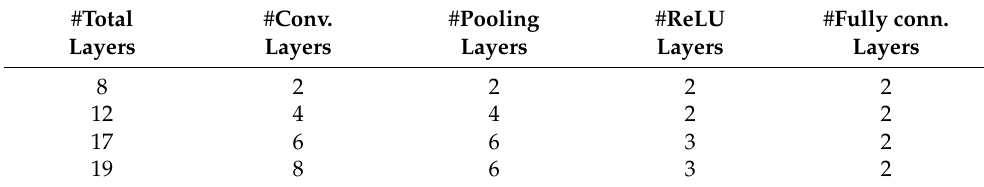
Table 4. CNNs with Different Depths (CIFAR-10).